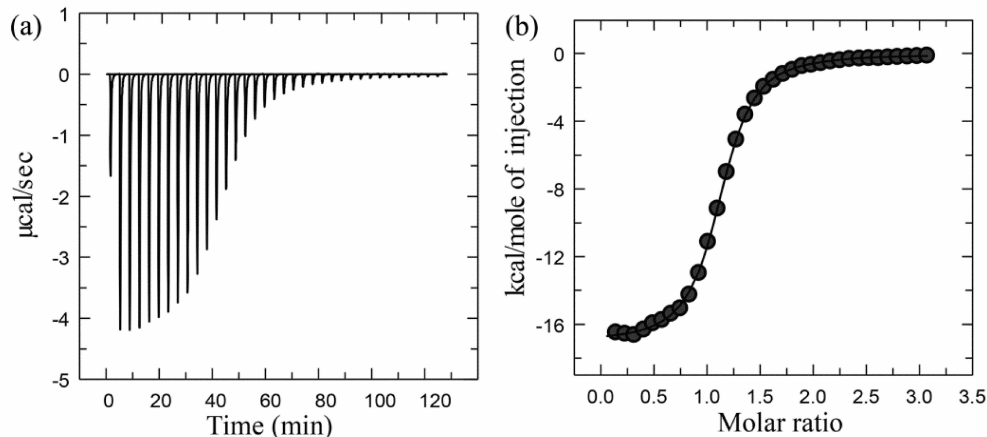
Figure 2. Representative ITC data for the binding of cytidine 2 1 -monophosphate (2 1 CMP) to RNaseA: ( a ) Primary raw data; ( b ) Binding curve derived from the raw data. Adapted from [7] Copyright 2008 with permission from Annual